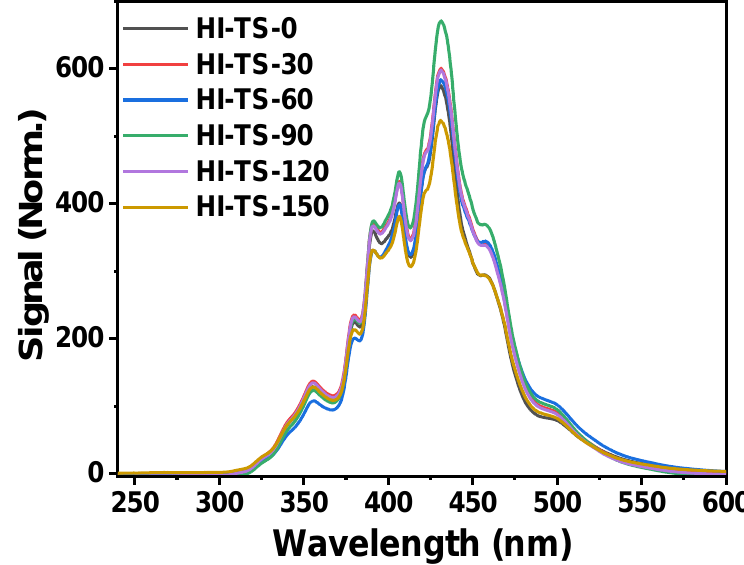
Figure 4. Fluorescence spectra of spinnable pitch incubated for 150 days to extract HI-TS. Table 4. Composition of HI-TS PAHs in spinnable pitch during incubation.